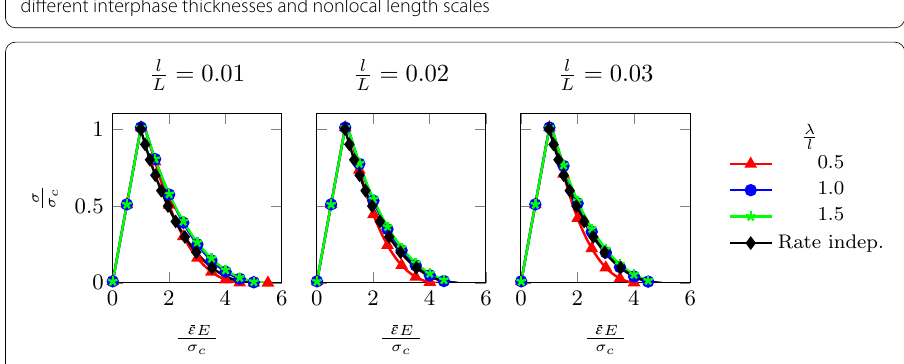
= 4 of the integral averaging model for c